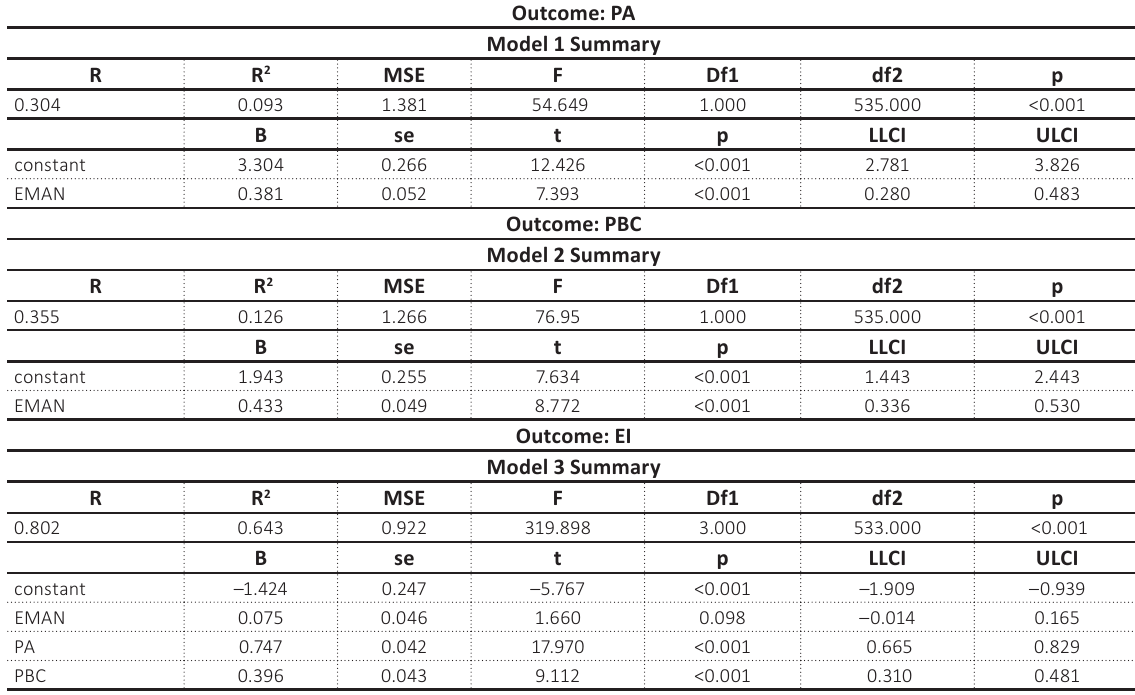
Table 3. Regression results for the mediation